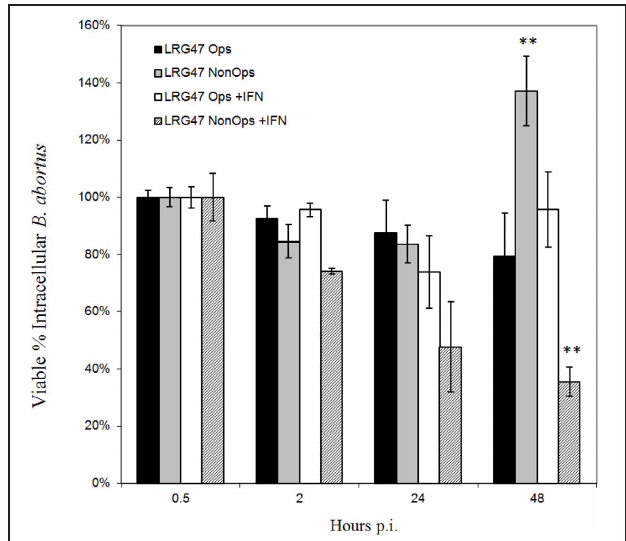
FIGURE A3 | Effects of opsonization on Brucella survival in LRG-47 knockout peritoneal macrophages. Peritoneal macrophages were collected from LRG-47 − / − mice and infected with Ig-opsonized or non-opsonized virulent Brucella abortus . Colony forming units (CFU) were enumerate at 30min, 2h, 24h, and 48h post infection and percent survival was calculated compared to CFU/ml 30min post infection. Ig-opsonized Brucella have a lower percent survival in the non-activated cells than they do in the activated cells suggesting a requirement for LRG-47 in opsonized Brucella survival in non-activated macrophages. In IFN- γ stimulated cells the percent survival of the Brucella steadily decreases over the duration of 48h whereas in the non-activated cells there is a sharp increase in percent survival between 24 and 48h post infection. ( ∗∗ p ≤ 0.01 Student’s t -Test vs. opsonized for each stimulation